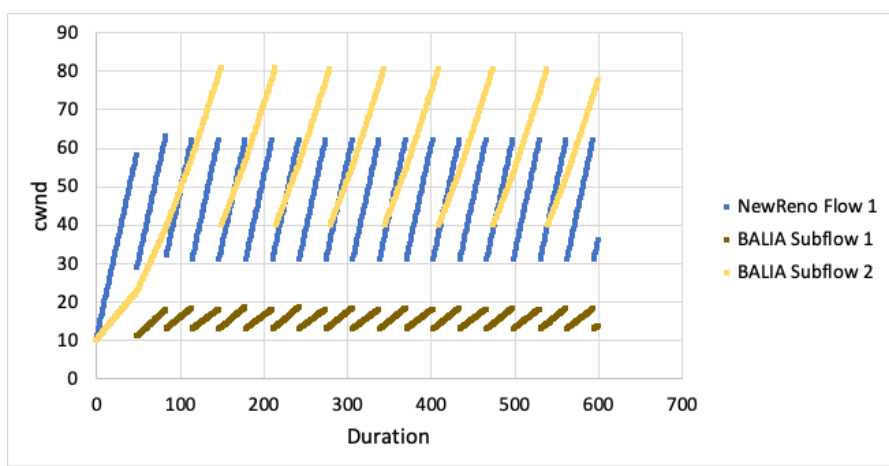
Figure 10. OLIA—Competing Window Growth—Same RTT.